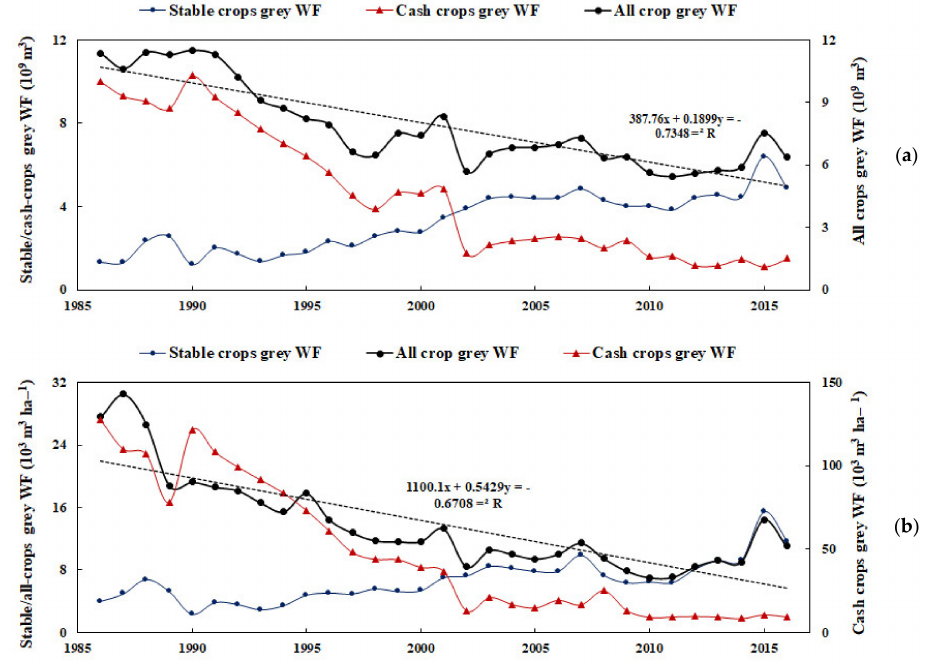
Figure 9. Evolution of total (m 3 y − 1 , ( a )) and per capita (m 3 cap − 1 , ( b )) grey WF related to cash/staple crop production in the Khuzestan province over the period